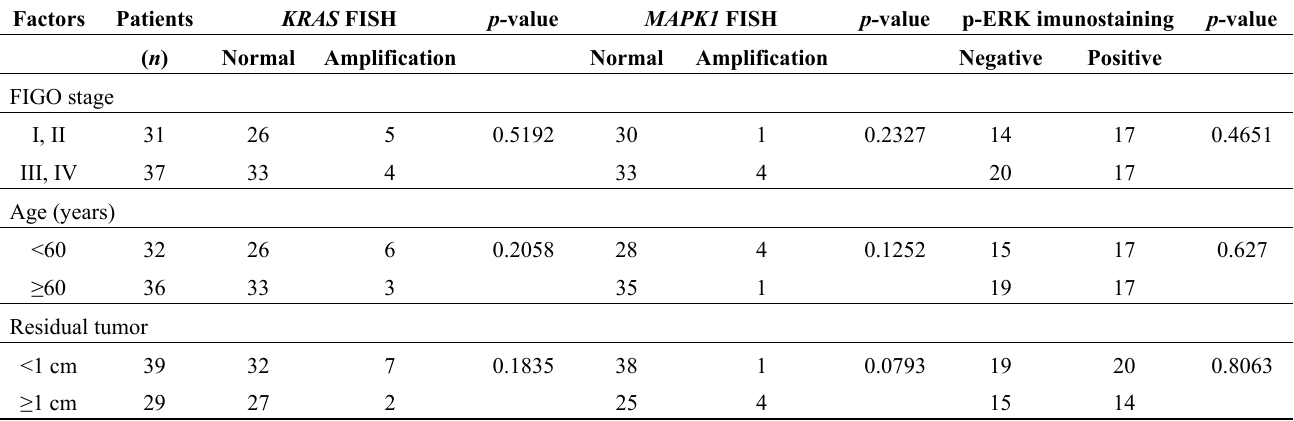
Table 2. Association between KRAS or MAPK1 gene amplification or p-ERK expression and clinicopathological factors in patients with type II ovarian